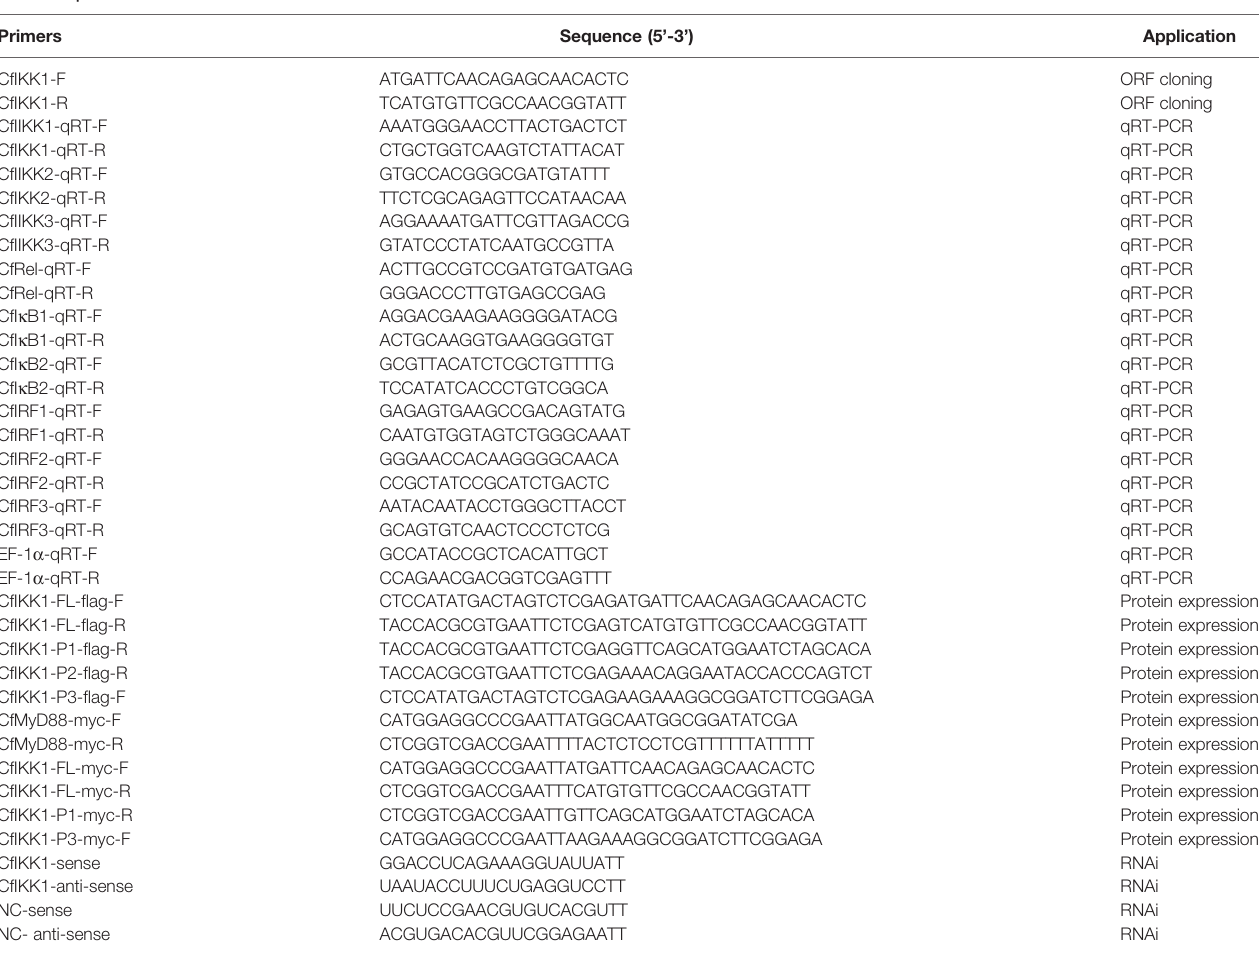
TABLE 1 | Primers used in this